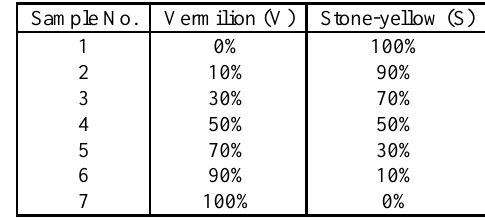
Table 1 Mixing formula of mineral pigment samples